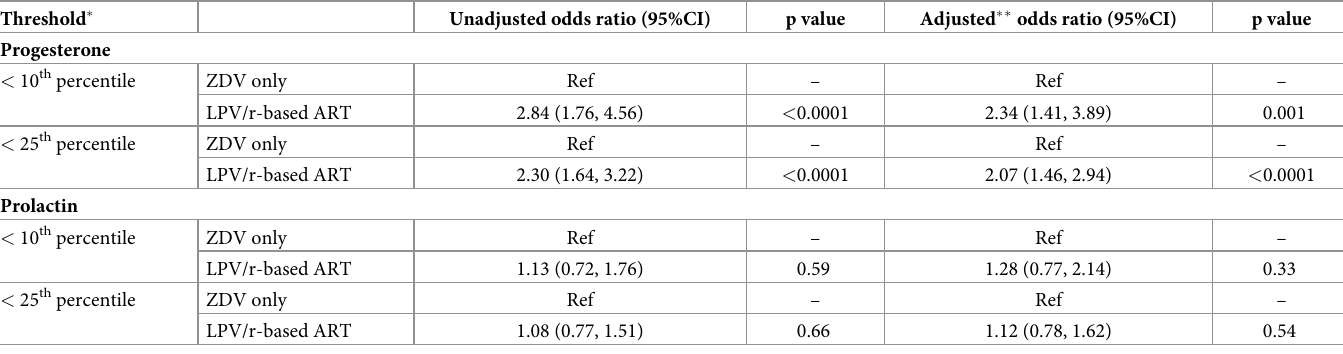
Table 2. Relationship of antiretroviral regimen arm and odds of low hormone levels.